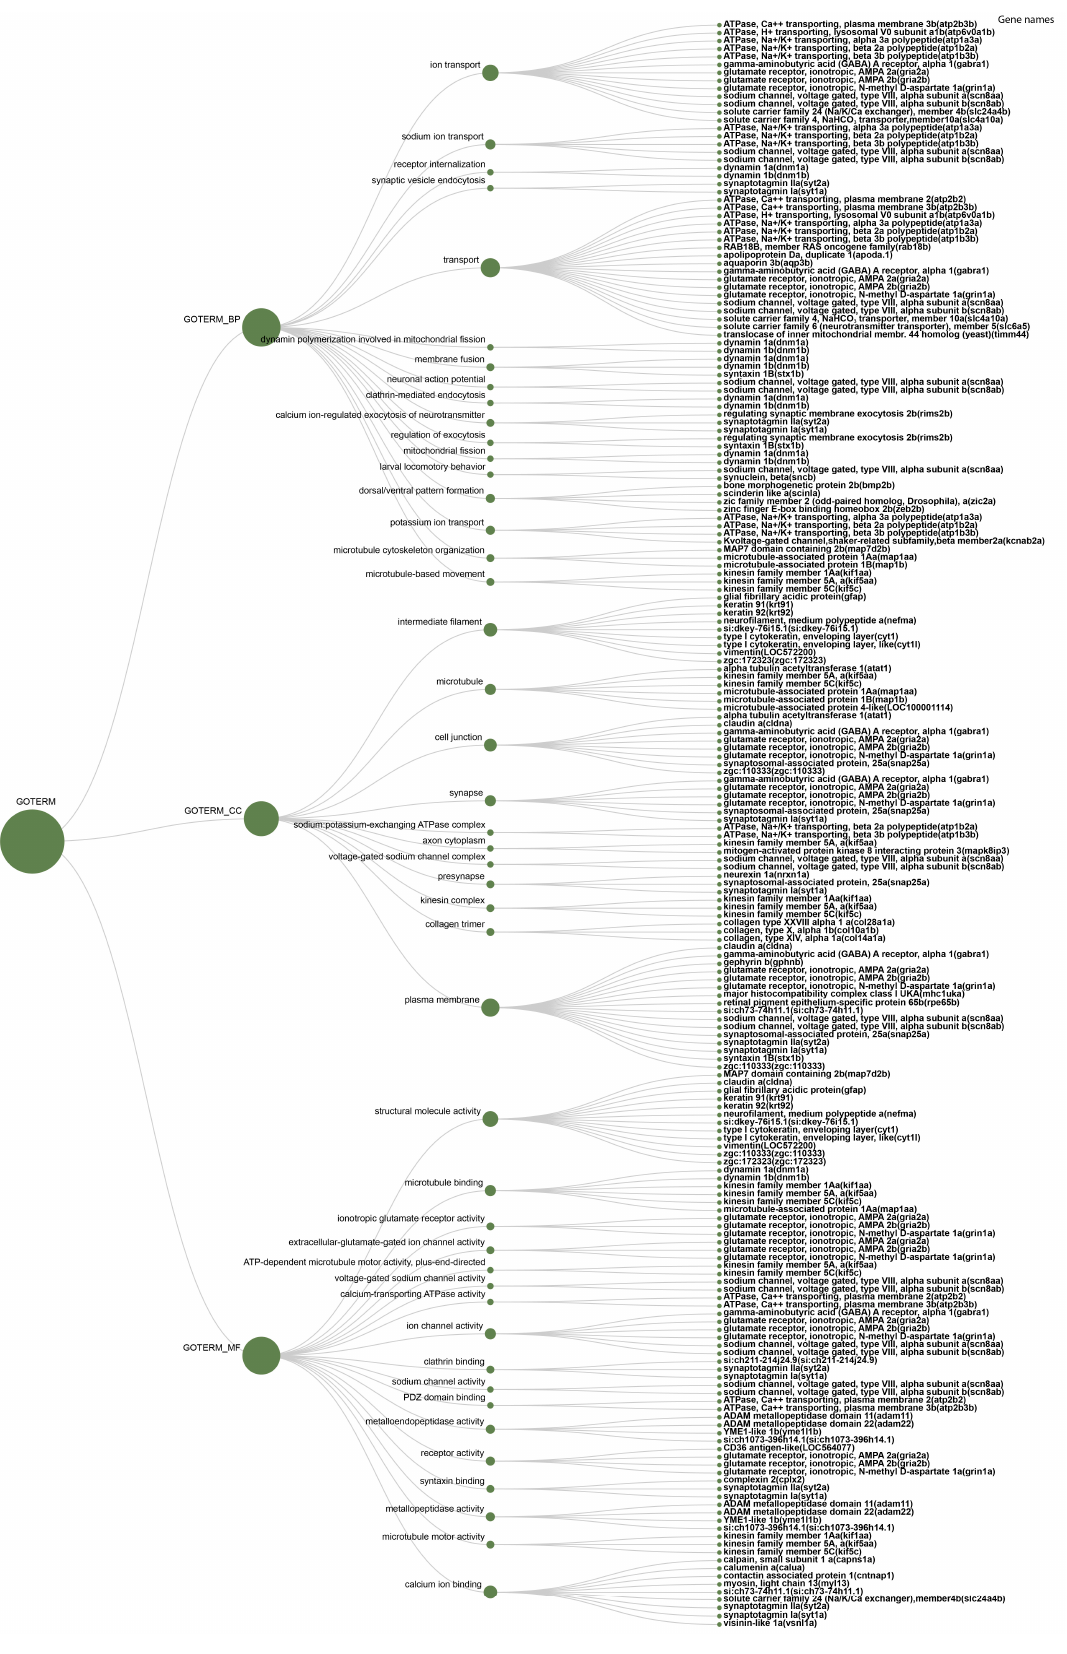
Figure 3. Gene ontology, Biological function (BF), Molecular function (MF), Cellular component (CC). The gene names appear to the left of the